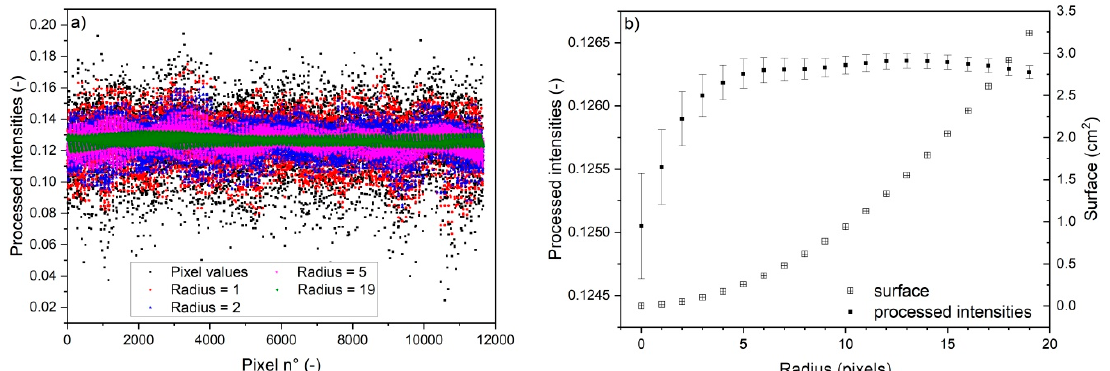
Figure 4. Representation of intensities after 72 h in the left upper side of the flow chamber: ( a ) intensities of the 11,664 pixels of a 5 × 5 cm 2 square for pixel unity and derived as median of squares of 1 px, 2 px, 5 px and 19 px radius. ( b ) Solid black square symbols depict the mean of the pixel and median values (median smoothing with radius from 1 to 19 px) and attached error bars represent 95% confidence interval. Curve with empty square symbols with plus center shows the corresponding area of measurement (right axis of the graphic).